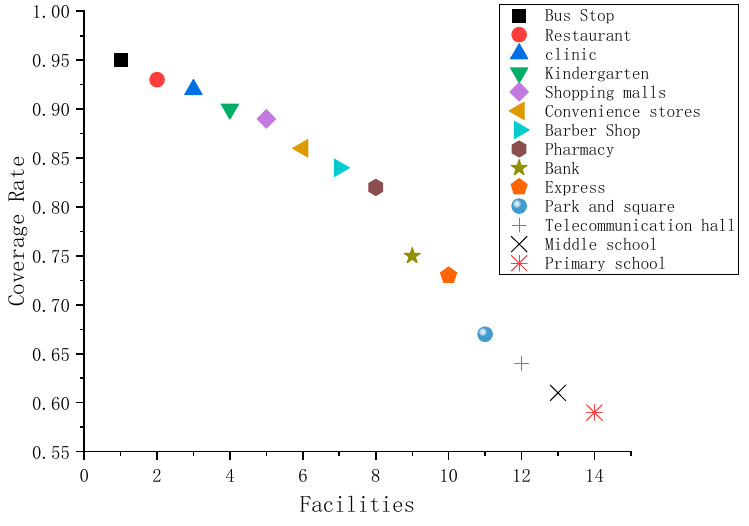
Figure 3 . Facility average coverage. Figure 3. Facility average